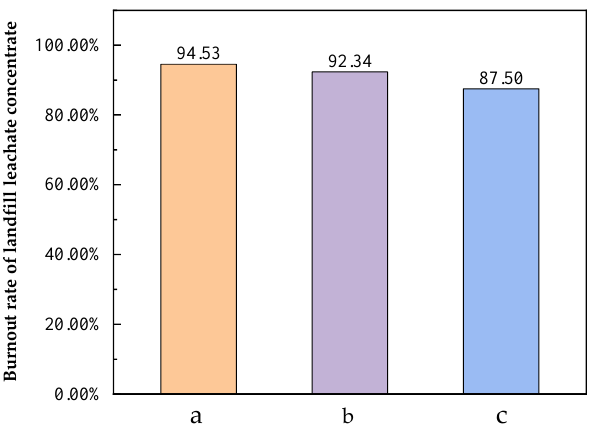
Figure 6. The complete combustion ratio of concentrated liquid under three different burner arrangements: ( a ) symmetrical arrangement of burners with reverse swirl; ( b ) symmetrical arrangement of burners with same direction flow; ( c ) burner-staggered arrangement with same direction flow.